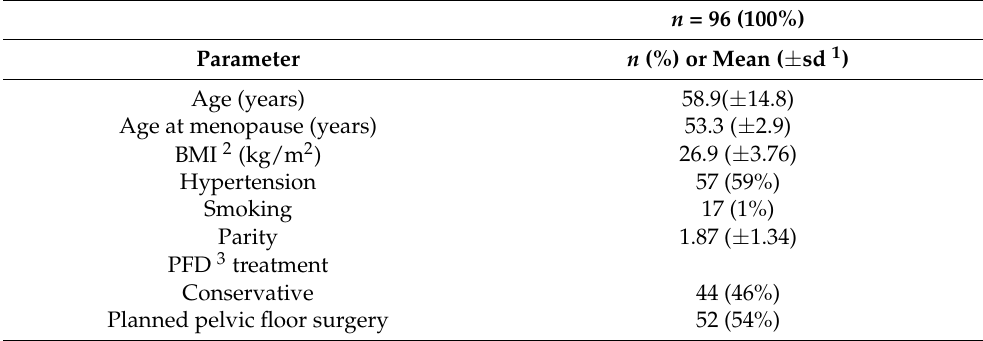
Table 2. Negative changes of quality of live during COVID-19 lockdown.